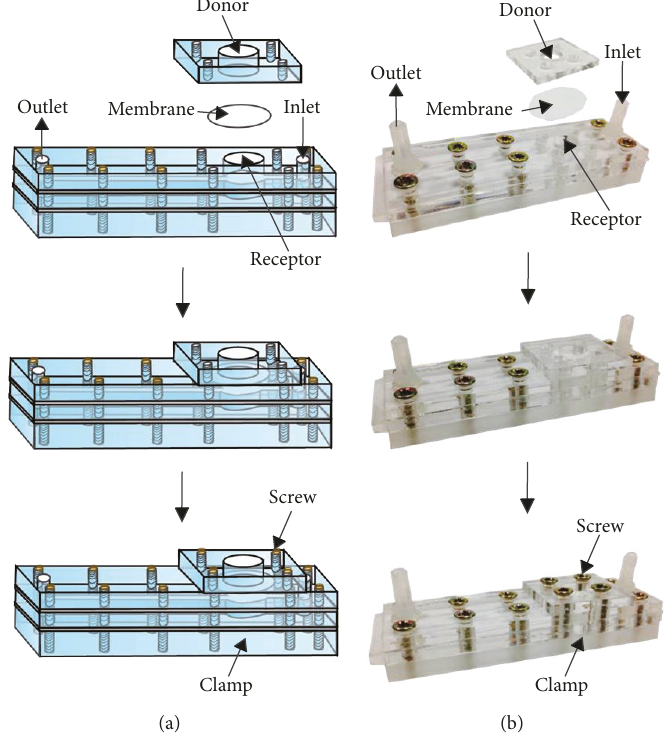
Figure 2: Composition of the diffusion microchip device: (a) schematic and (b) photograph.